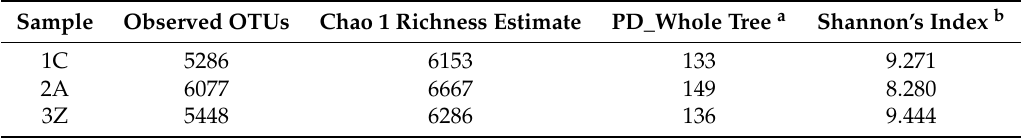
Table 2. Alpha diversity metrics for the samples. 1C—control (untreated soil); 2A—Ag nanoparticle-treated soil; and 3Z—ZnO nanoparticle-treated soil.